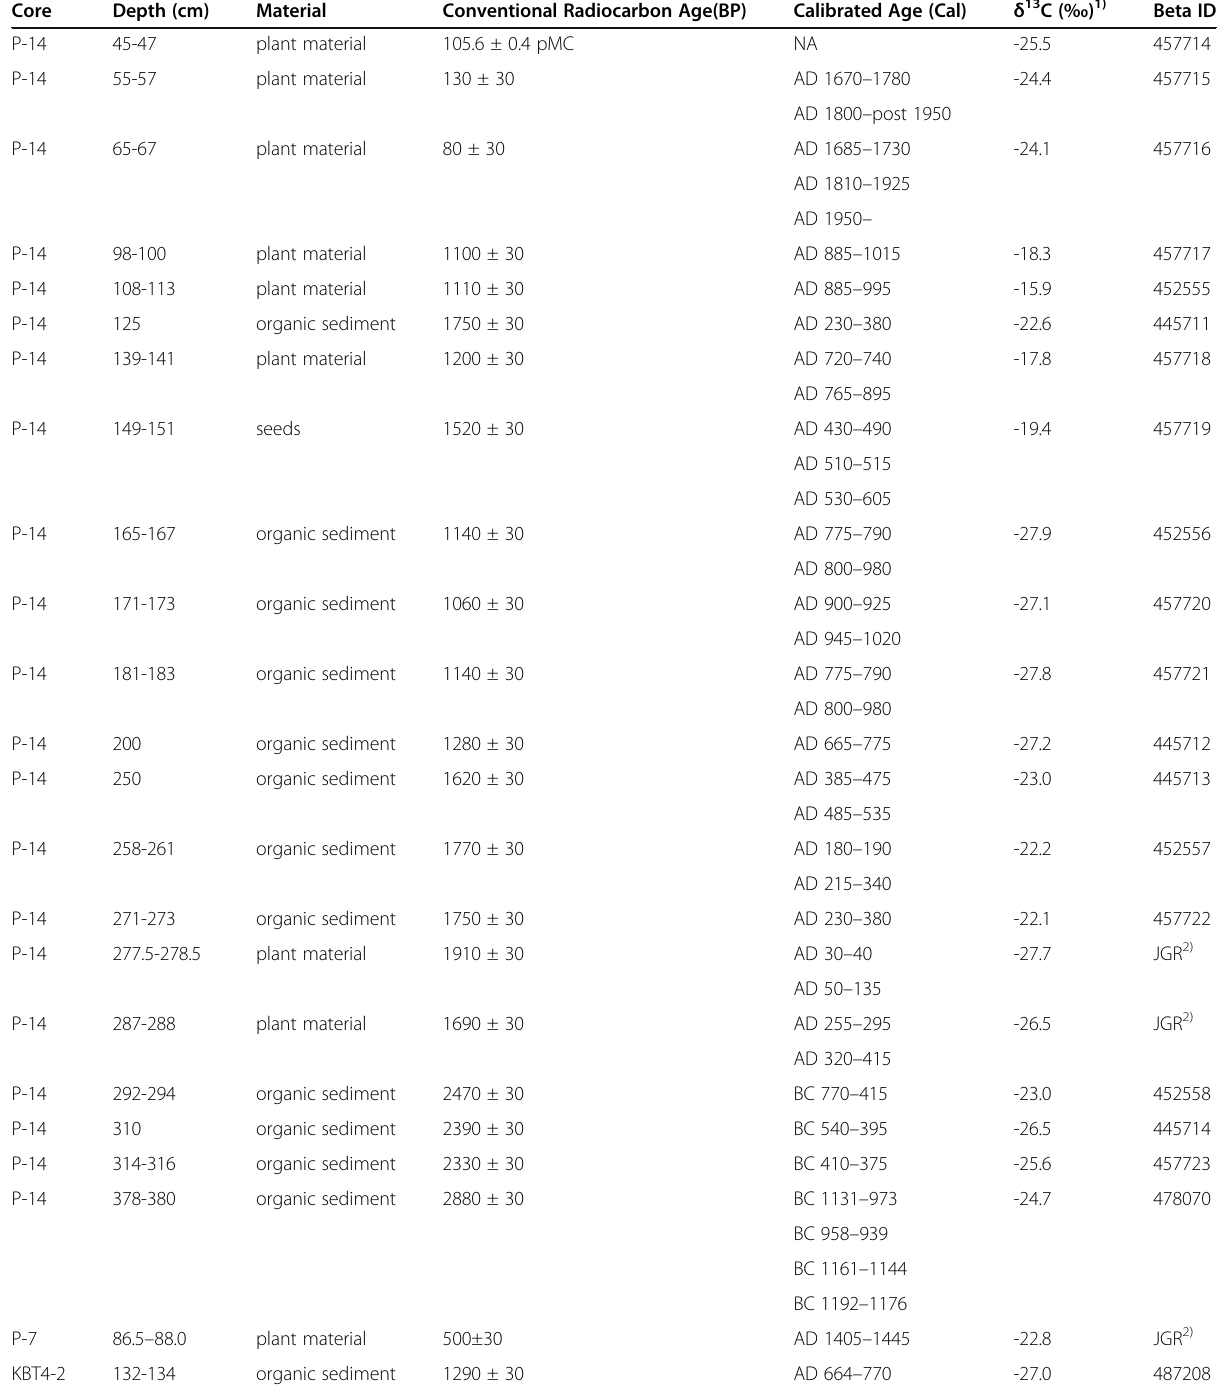
Table 2 Radiocarbon dating